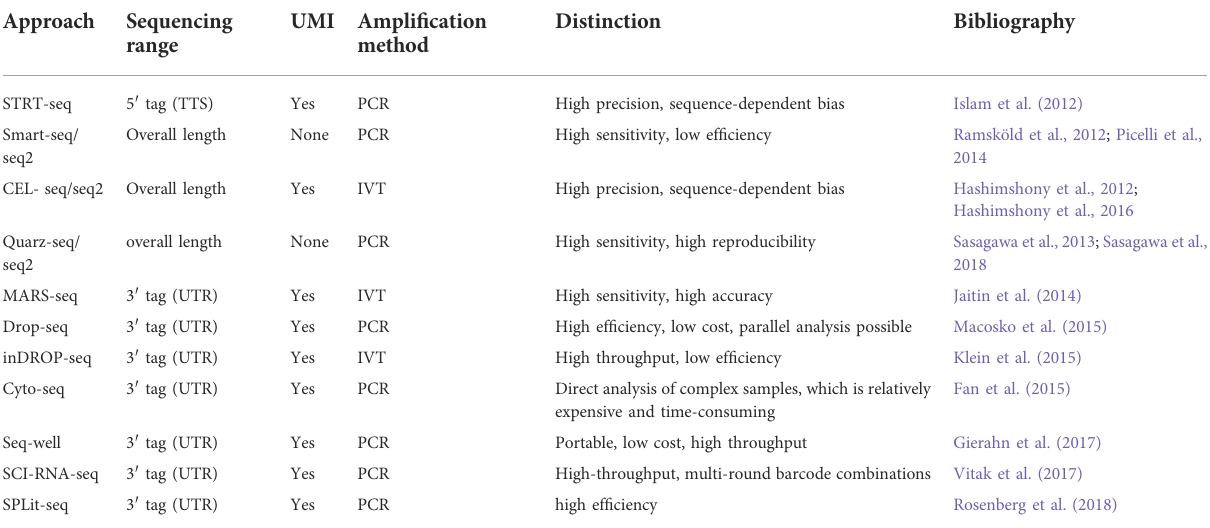
TABLE 2 Comparison of different scRNA SEQ